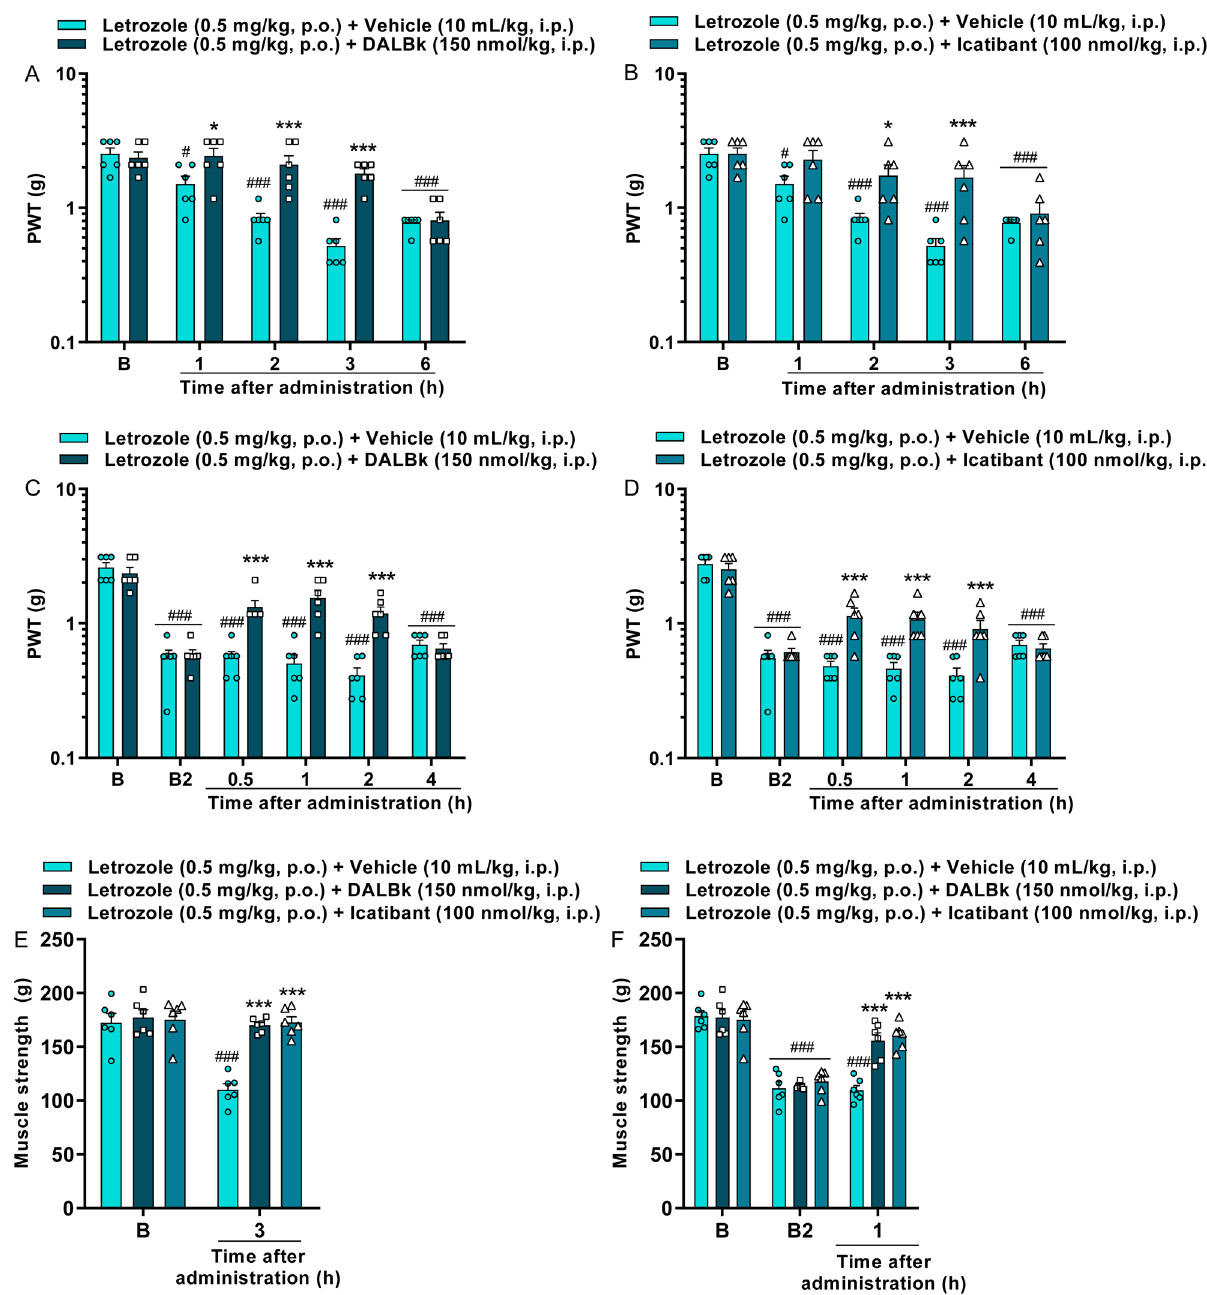
Figure 3. Kinin B 1 (DALBk 150 nmol/kg, i.p.) and B 2 (Icatibant 100 nmol/kg, i.p.) receptor antagonists relieve mechanical allodynia and reduction on the muscle strength caused by the aromatase inhibitor letrozole (0.5 mg/kg, p.o.). Time-response curve for mechanical allodynia after treatment with DALBk or Icatibant injected 15 min before letrozole administration ( A , B ). Time-response curve for mechanical allodynia after treatment with DALBk or Icatibant injected 2 h after letrozole administration ( C , D ). Measure muscle strength after treatment with DALBk or Icatibant injected 15 min before ( E ) or 2 h after ( F ) letrozole administration. (B) Denotes baseline mechanical threshold or muscle strength before drug administration while B2 indicates baseline threshold at 2 h after letrozole administration. Results are presented as mean + SEM (n = 6/group; C57BL/6 mice). # P < 0.05; ### P < 0.001 compared to baseline threshold (B). *P < 0.05; ***P < 0.001 compared to the vehicle group. Two-way ANOVA repeated-measures followed by Bonferroni’s post hoc test. PWT paw withdrawal